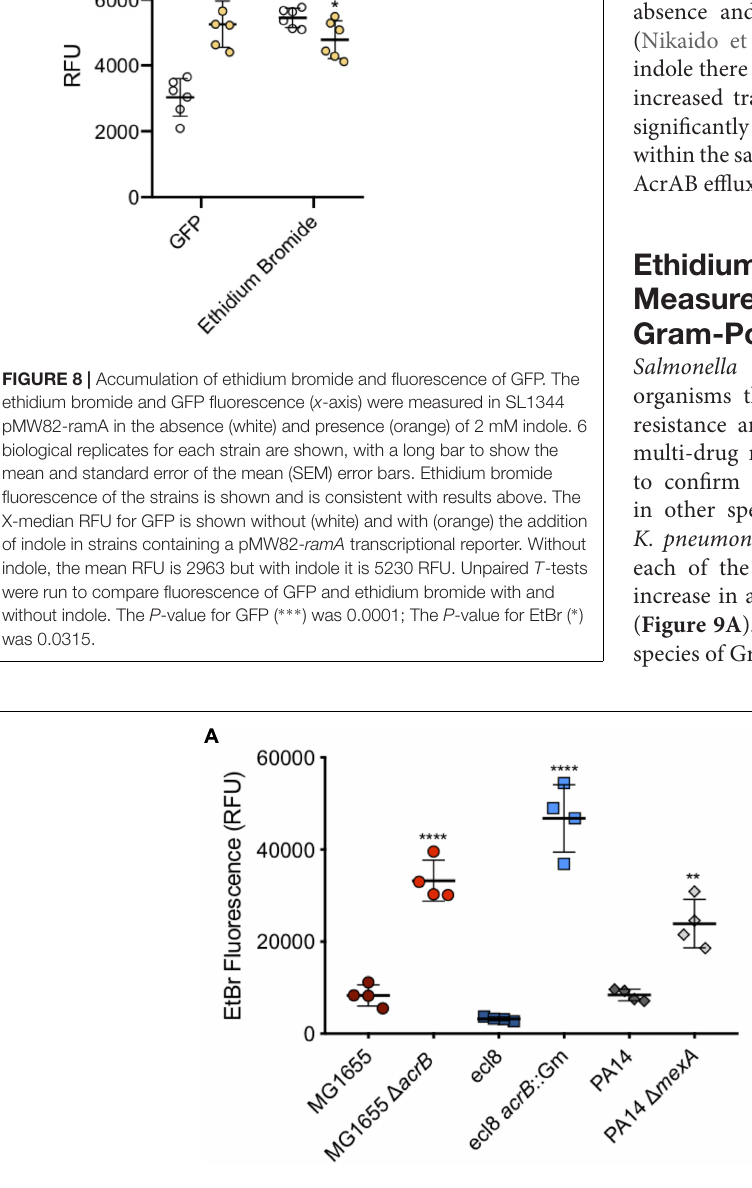
Frontiers in Microbiology |